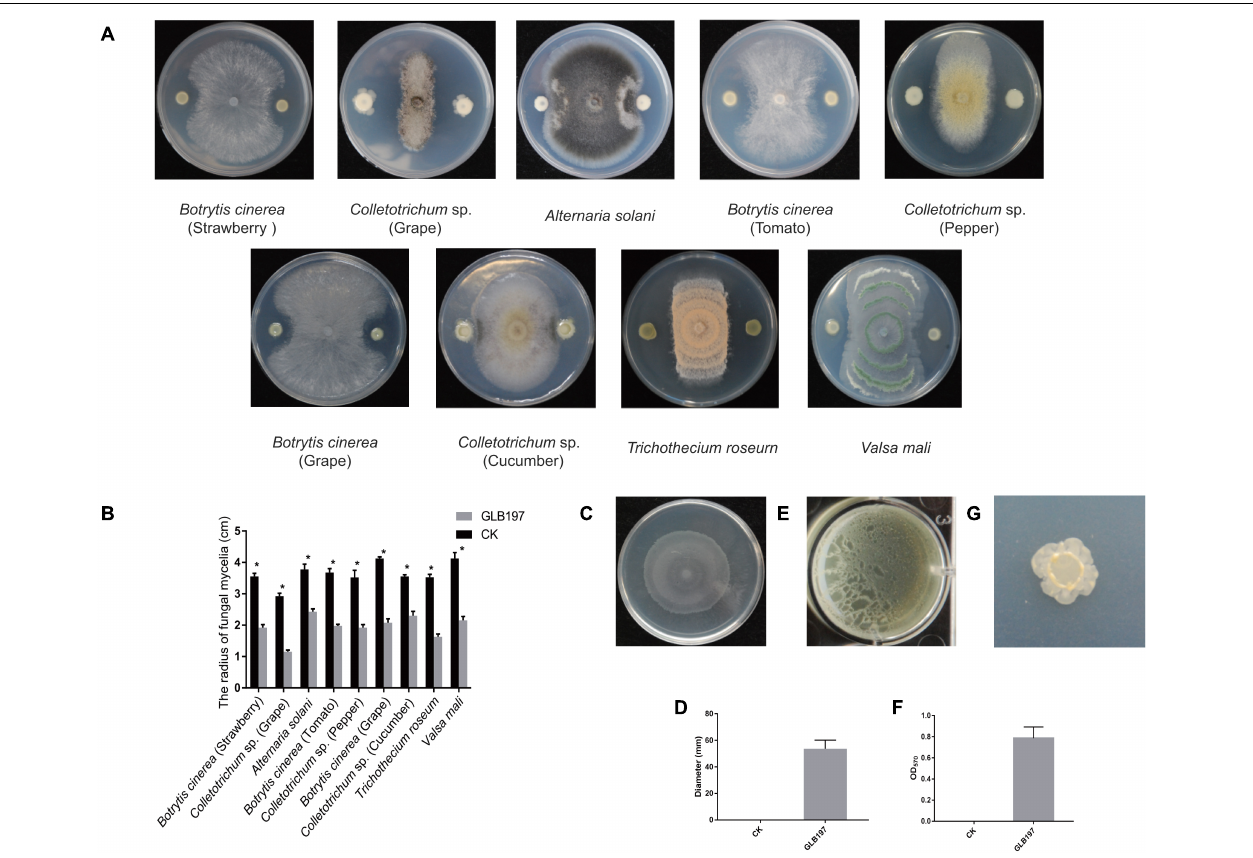
FIGURE 1 | The features of B. altitudinis GLB197. (A) The antagonistic activity of GLB197 against nine pathogenic fungi on PDA plate. (B) Quantification of antagonistic activity of GLB197. * p < 0.01—significant differences compared with the control. (C) Swarming ability of GLB197 was assessed. (D) Data presented are the swarming ability of GLB197 on LB plates 5 h later. The data are expressed as the mean ± SD ( n = 5). CK represented by LB medium and GLB197 represented by the strain. (E) Pellicle formation by GLB197 on Msgg liquid media. (F) OD readings from 12-well plate assays of biofilm formation by GLB197. The data are expressed as the mean ± SD ( n = 6). (G) The colony morphology on MSgg plates was monitored for strain